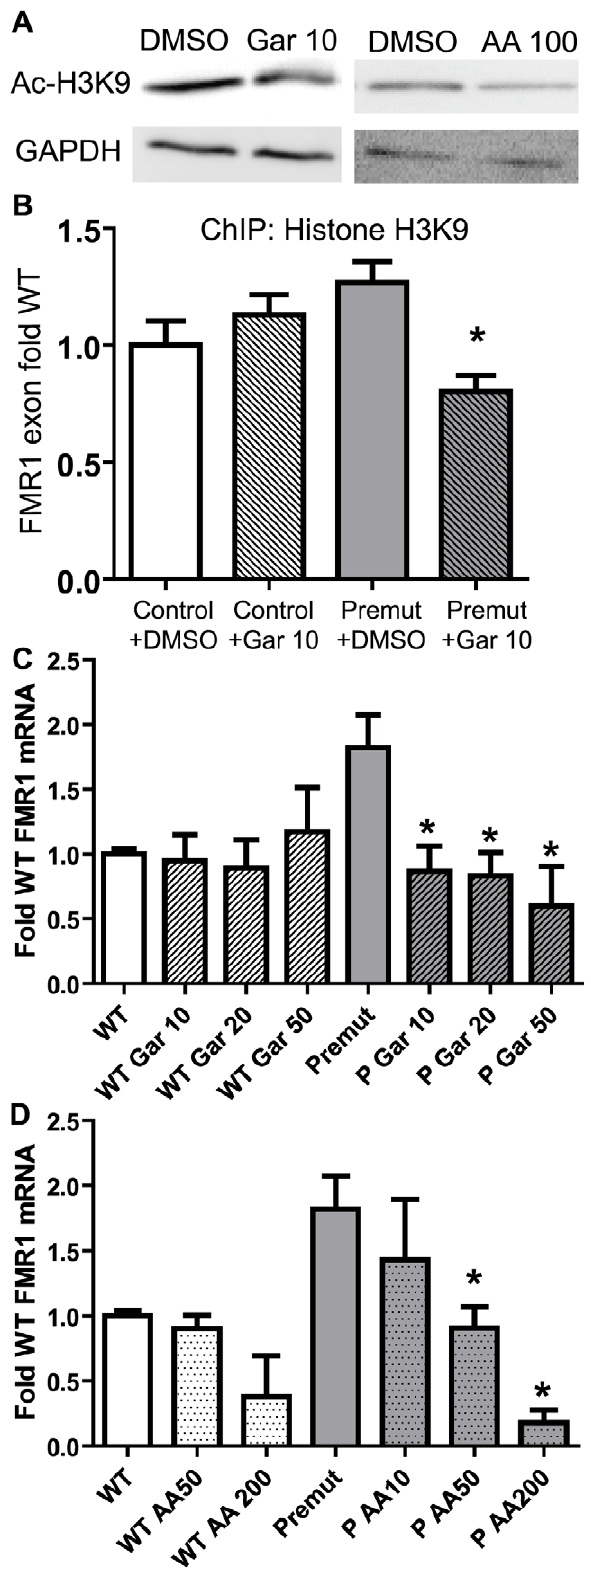
Figure 6. Correction of elevated FMR1 mRNA expression by treatment with histone acetyltransferase inhibitors. A) Pre- mutation carrier derived lymphoblastoid cell lines treated with DMSO, 10 m M garcinol, or 50 m M anacardic acid, for 24 hours are subjected